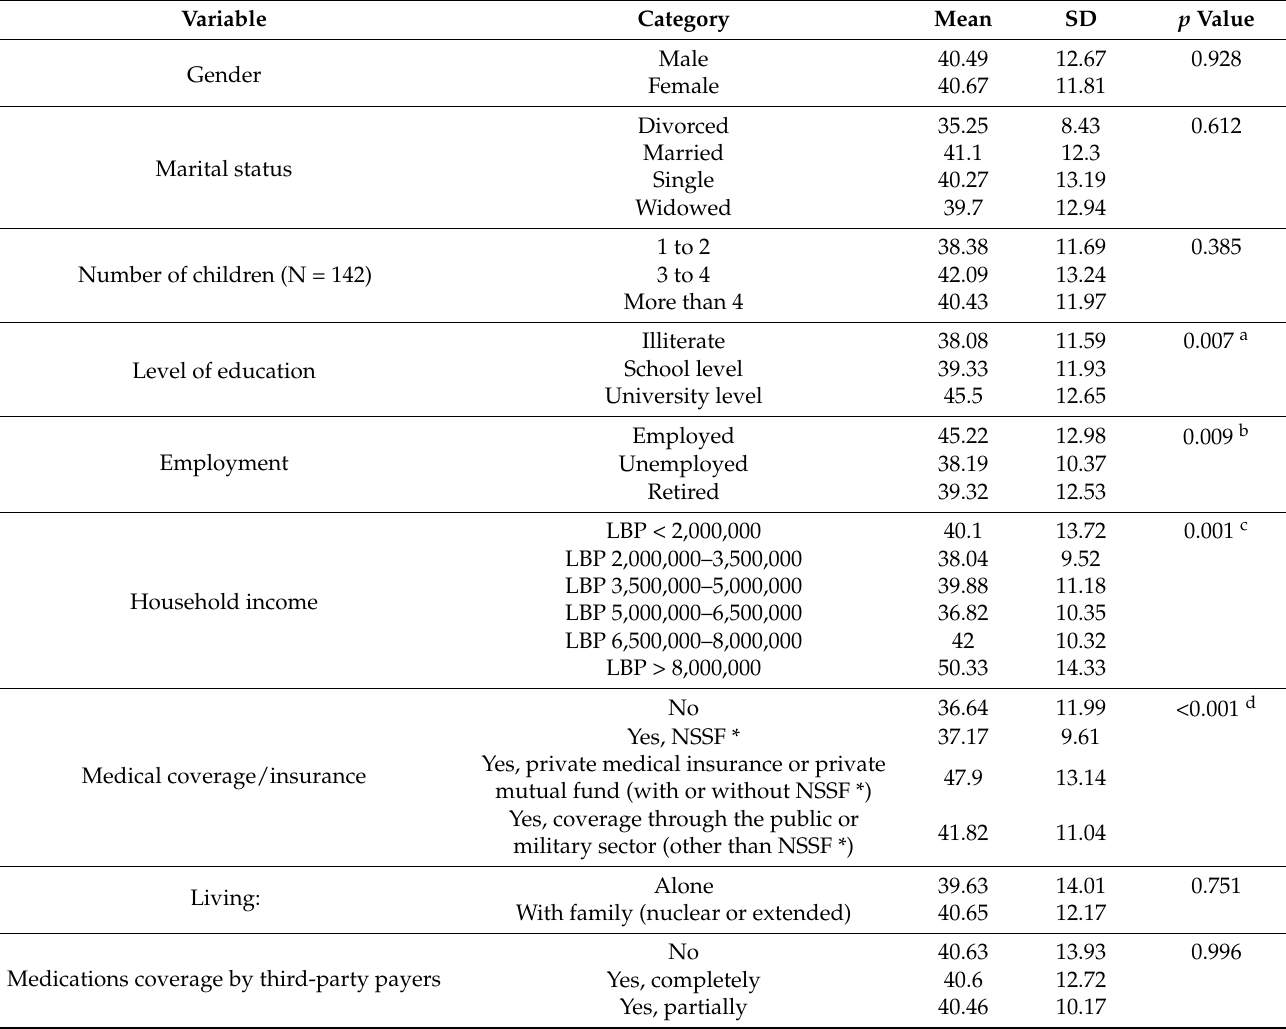
Table 5. Bivariate analysis of the socioeconomic, sociodemographic, and therapeutic characteristics of the patients taking the SS-QOL-17 as the dependent